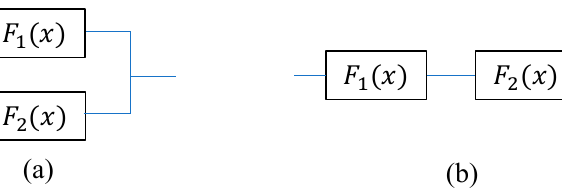
Figure 2. Structure of different failure models for two components: ( a ) in the parallel mode and ( b ) in the serial mode.